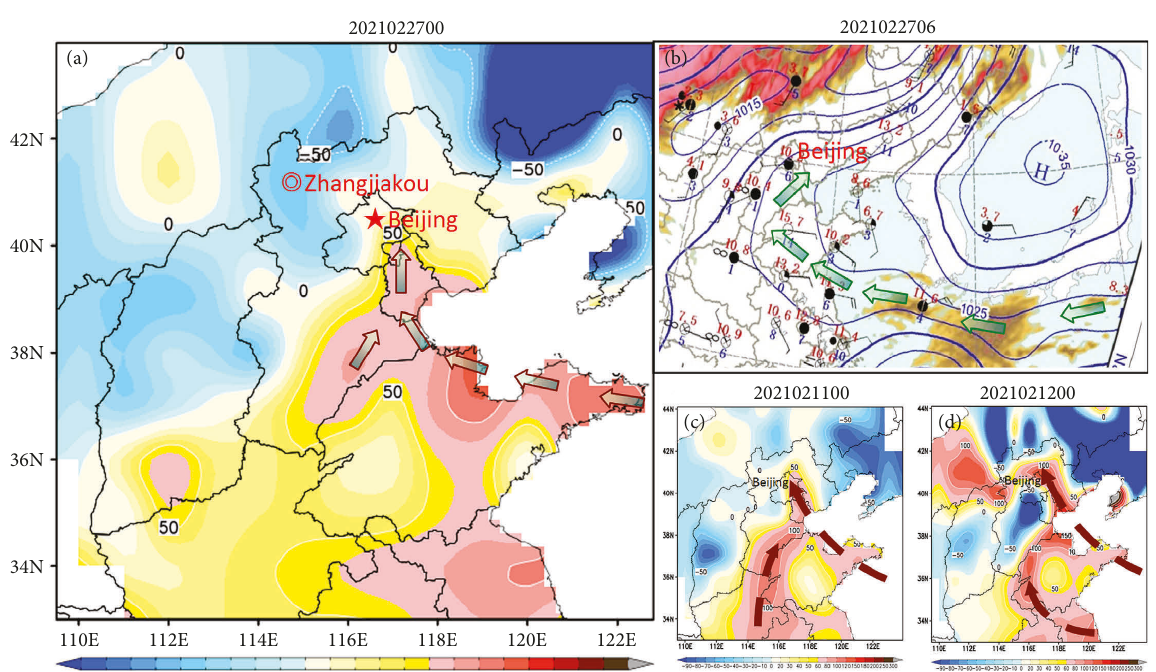
Figure 7: (a) Directed transport of pollution meteorological conditions index (PLAM ⟶ obj ) to Beijing at 00:00 on February 27, 2021, (b) surface weather map of Beijing–Tianjin–Hebei region at 06:00 on February 27, 2021, (c) directed transport of pollution meteorological conditions index (PLAM ⟶ obj ) to Beijing at 00:00 on February 11, 2021, and (d) directed transport of pollution meteorological conditions index (PLAM ⟶ obj ) to Beijing at 00:00 on February 12,